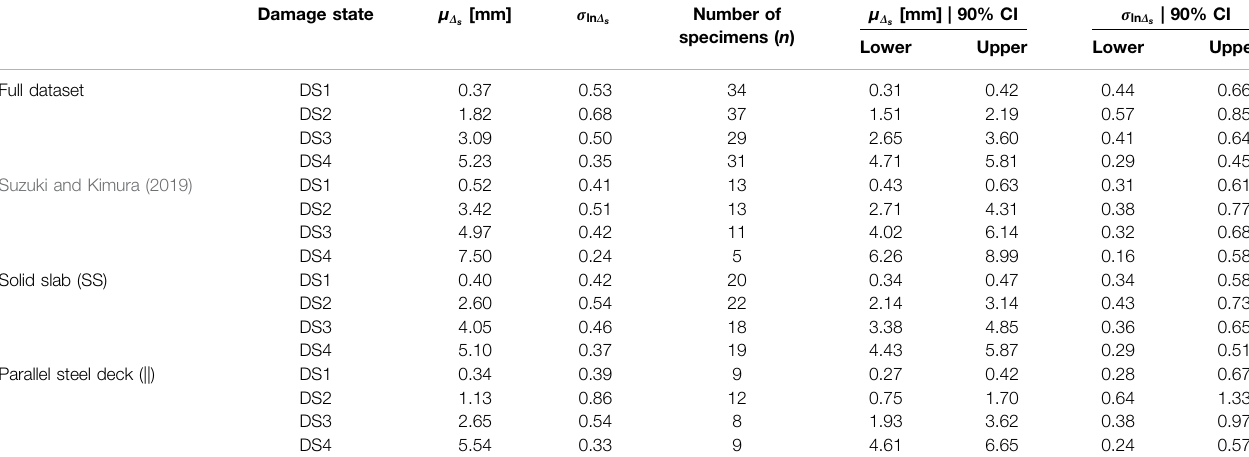
TABLE 2 | Statistical parameters of the lognormal distributions for each damage state.